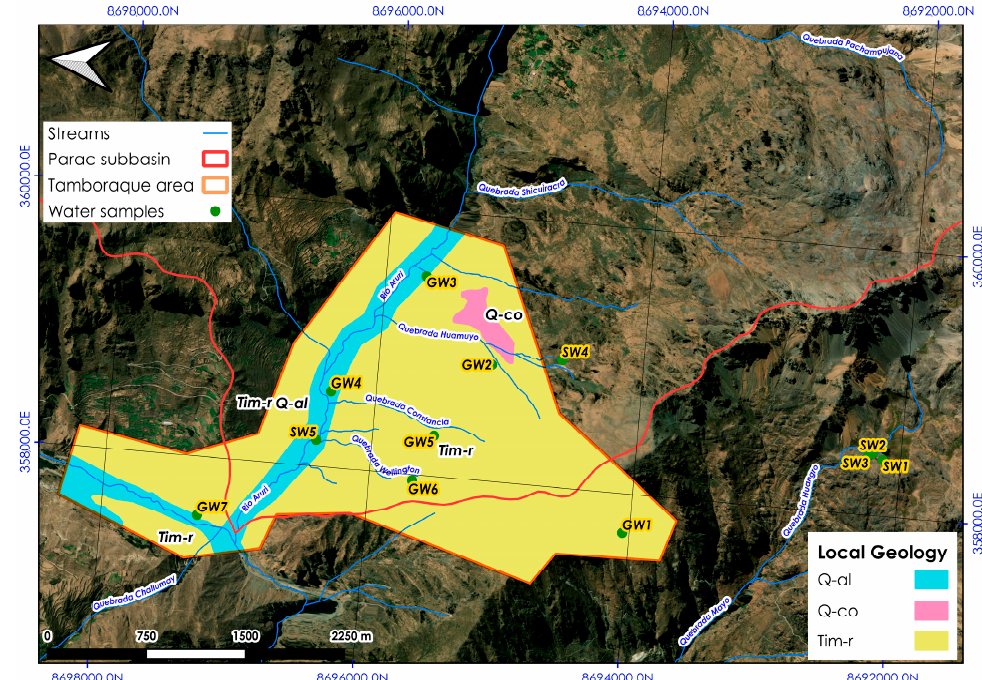
Figure 2. Geological map of the study area.